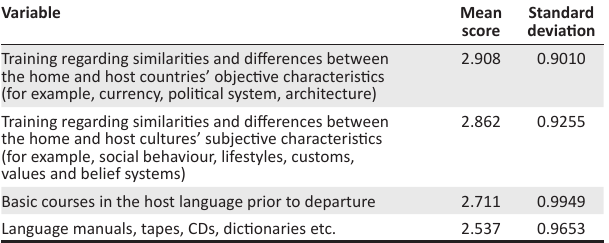
TABLE 8: Mean scores for training